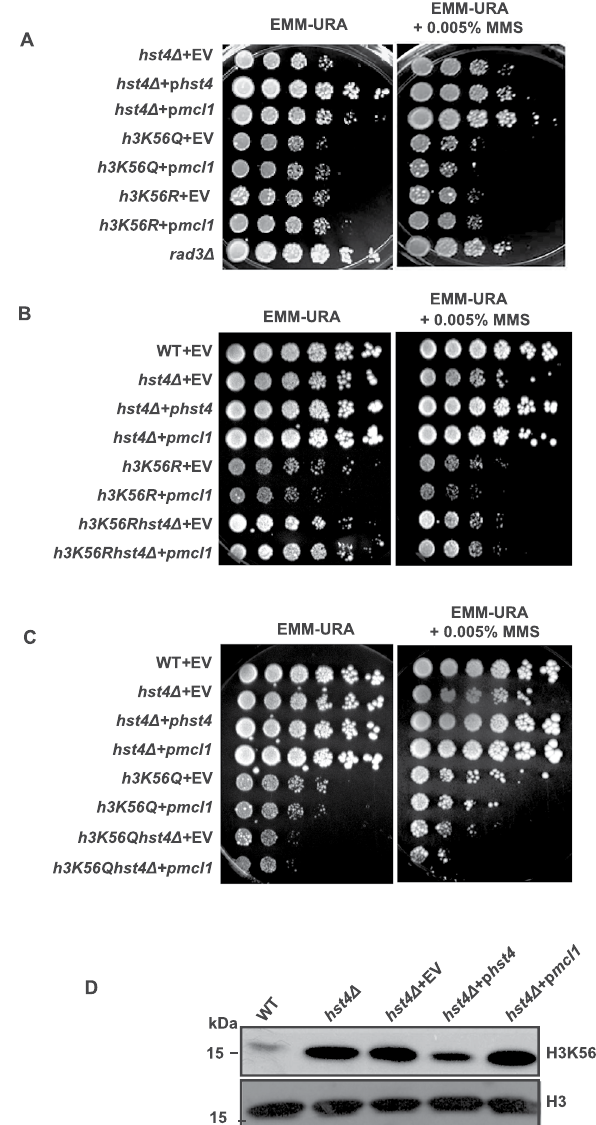
Figure 6. Suppression of hst4 Δ phenotypes by Mcl1 is dependent of H3K56ac. ( A ) hst4 Δ (ROP58) expressing hst4 , mcl1 or pSLF272 (empty vector), h3K56Q (ROP247) or h3K56R (ROP253) expressing mcl1 or pSLF272 (empty vector) and rad3 Δ (ROP266) were grown to OD 1, five-fold serial dilutions were prepared and spotted on to EMM-Ura or EMM-Ura + 0.005% MMS plates. ( B ) hst4 Δ (ROP58) expressing hst4 , mcl1 or pSLF272 (empty vector), h3K56R (ROP253), h3K56Rhst4 Δ (ROP275) expressing mcl1 or pSLF272 (empty vector) grown to OD 1, five-fold serial dilutions were prepared and spotted on to EMM-Ura or EMM-Ura + 0.005% MMS, or EMM-Ura + 0.01% MMS plates. ( C ) hst4 Δ (ROP58) expressing hst4 , mcl1 or pSLF272 (empty vector), h3K56Q (ROP247), h3K56Qhst4 Δ (ROP276) expressing mcl1 or pSLF272 (empty vector) grown to OD 1, five-fold serial dilutions were prepared and spotted on to EMM-Ura or EMM-Ura + 0.005% MMS, or EMM-Ura + 0.01% MMS plates. ( D ) Indicated strains were grown to mid log phase at 30 °C, whole cell extracts were prepared and Western blot was performed using antibodies against H3K56ac and histone